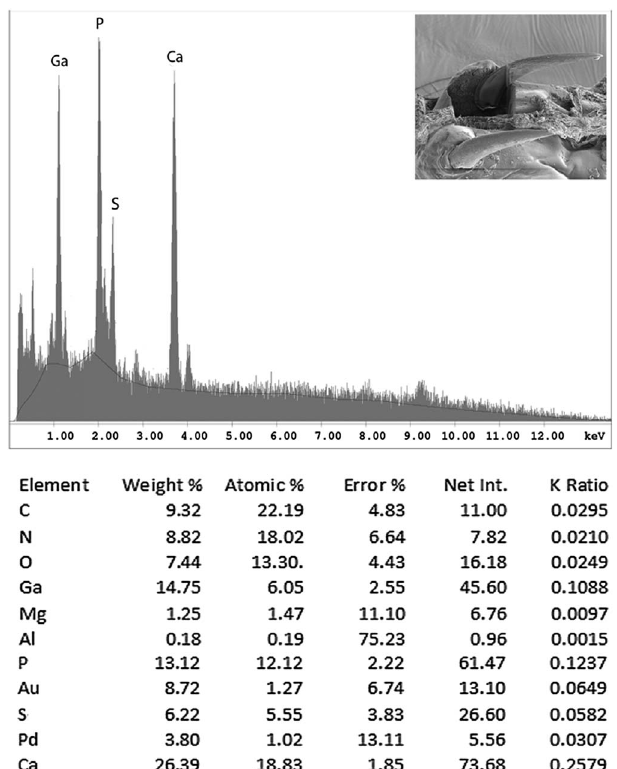
Figure 39. Energy dispersive X-ray spectrum of the tip of the anterior hook of a Neoechinorhynchus ponticus specimen from Chelon auratus in the Black Sea showing moderate levels of phosphorous, high levels of calcium, and moderate levels of sulfur. The X-ray data are the elemental analysis of the tip of the anterior hook (see bolded fi gures in Table 7). Insert: SEM of anterior